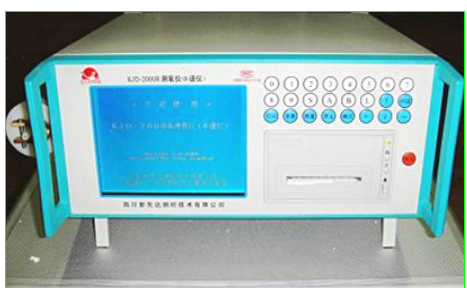
Figure 7. The photo of KCE.